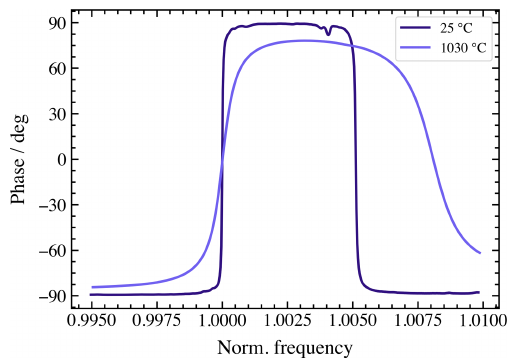
Figure 5. Temperature-dependent resonance frequency of an un- housed CTGS resonator (green dashed line) and of the same CTGS specimen after integrating it in the housing (red solid line). Up to about 800 ◦ C, no significant impact of housing is visible.